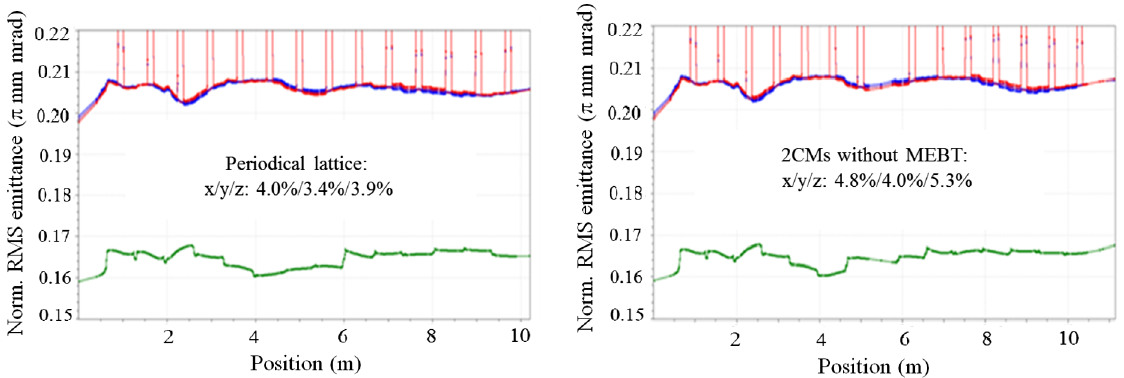
FIG. 16. The RMS envelope evolution of the Injector I SC section before (left graph: periodical lattice) and after (integrated with MEBT) separated in two cryomodules: horizontal, vertical and longitudinal are in blue, red and green